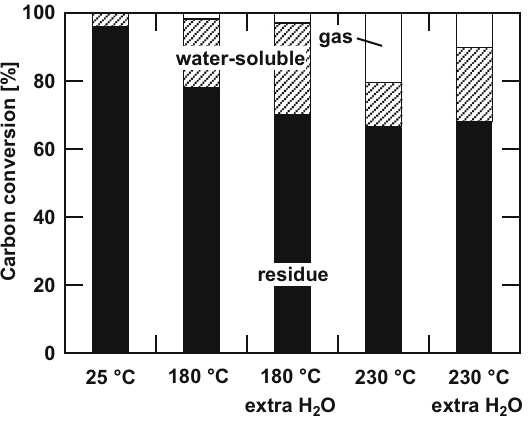
Figure 3: Carbon distributions under the several conditions of the hot water treatment with/without extra water